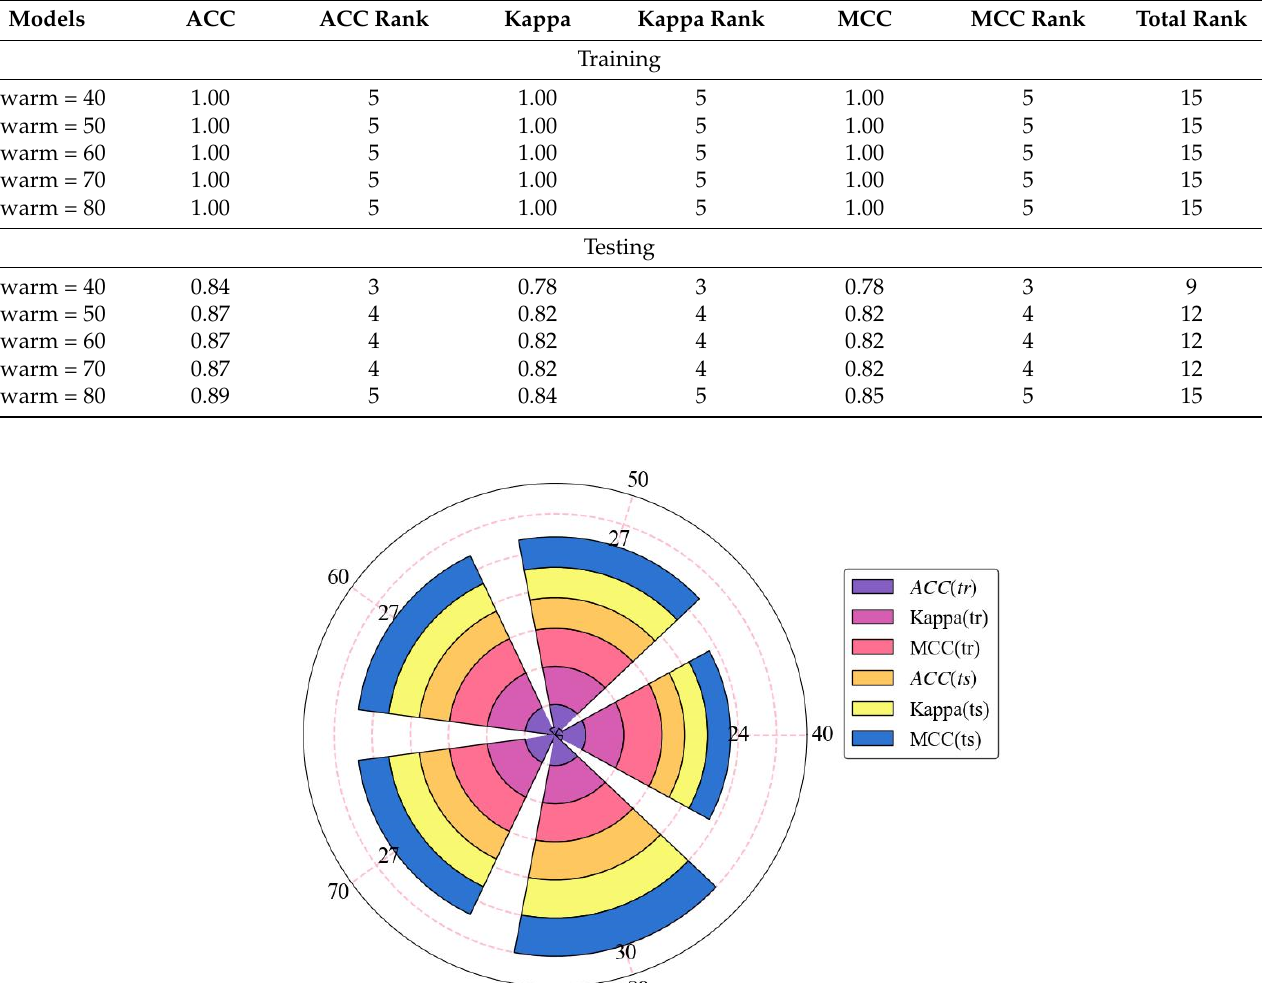
Figure 9. Schematic diagram to calculate ACC, Kappa, and MCC. Pe depicts expected agreement when both annotators assign labels randomly, t k represents the number of times class k truly occurred, p k is the number of times class k was predicted, c stands for the total number of samples correctly predicted, and s represents the total number of samples.